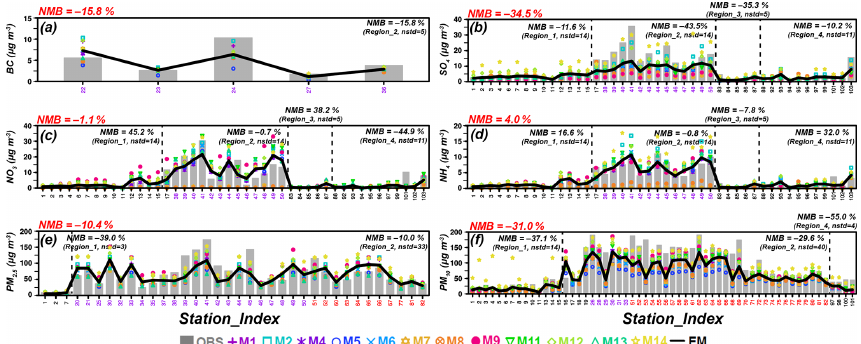
Figure 3. Comparison of observed and simulated concentrations of (a) BC, (b) SO 2 − panel, the grey bars represent observations, the colored dots represent simulations, and the solid black lines represent the MMEM (multi- model ensemble mean). The x axis presents the monitoring sites (the information of these sites is listed in Table S1 in the Supplement). Normalized mean biases (NMBs) between observations and MMEM in each defined subregion (shown in black) and the entire analyzed region (shown in red) are also shown. In this figure, the annual mean observations are taken from EANET, CNEMC, and published